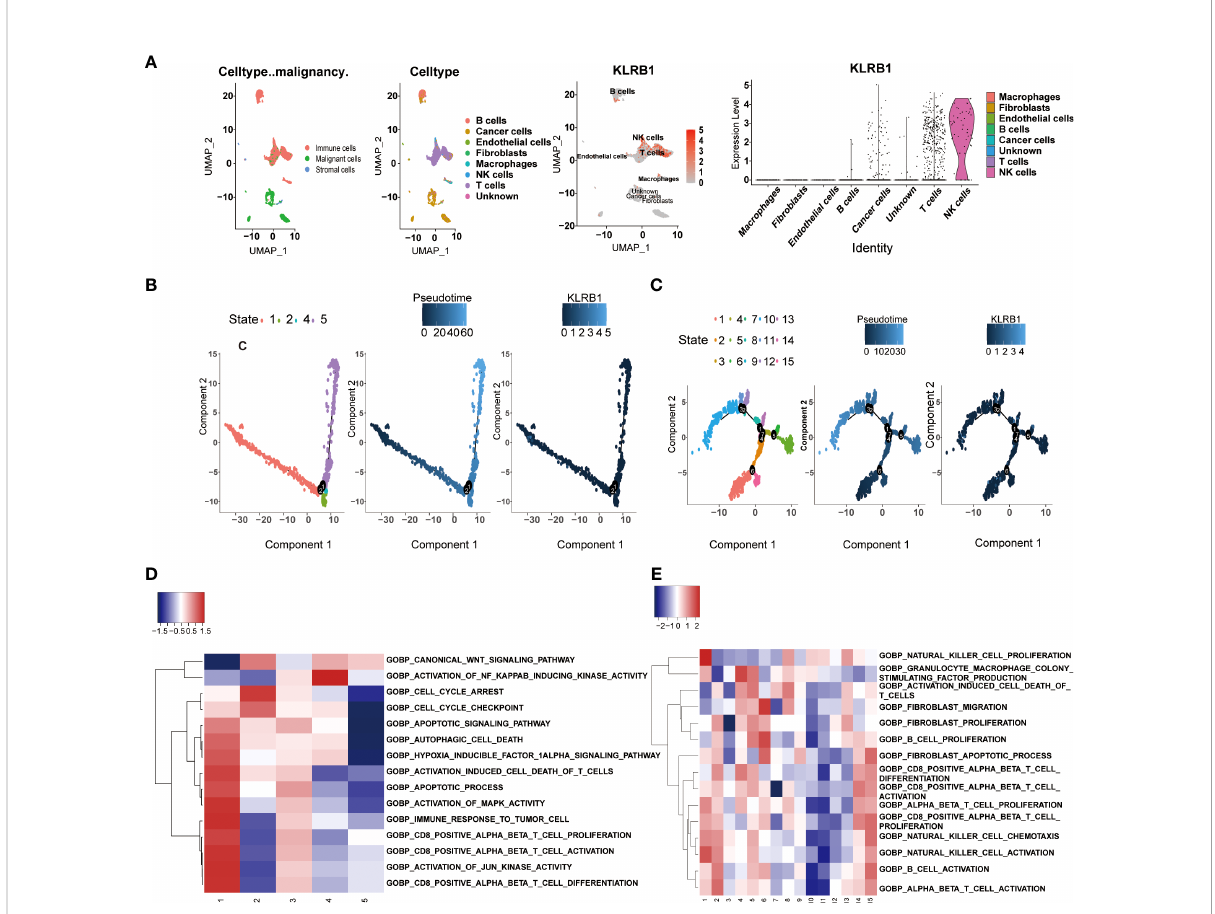
FIGURE 6 scRNA-seq results for CD161 in SKCM. The expression levels of CD161 in tumor and immune cells are based on the R package copykat in SKCM (A) . The single-cell trajectory of cancer cells contains three main branches. Cells in images are colored based on state (left), pseudotime (middle), and KLRB1 (right) (B) . The single-cell trajectory of T cells contains seven main branches. Cells in images are colored based on state (left), pseudotime (middle), and KLRB1 (right) (C) . GSEA of cancer cells for KLRB1 in each state (D) . GSEA of macrophages for KLRB1 in each state (E) . The red color indicates a positive correlation, while the blue color indicates a negative